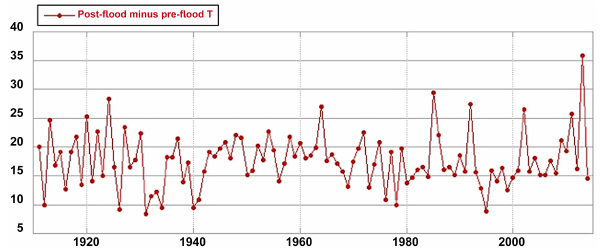
Figure 2. Temperature plot showing the post flood temperature mi- nus the pre-flood temperature, demonstrating that Interior Alaska experienced coldest April and May in decades in